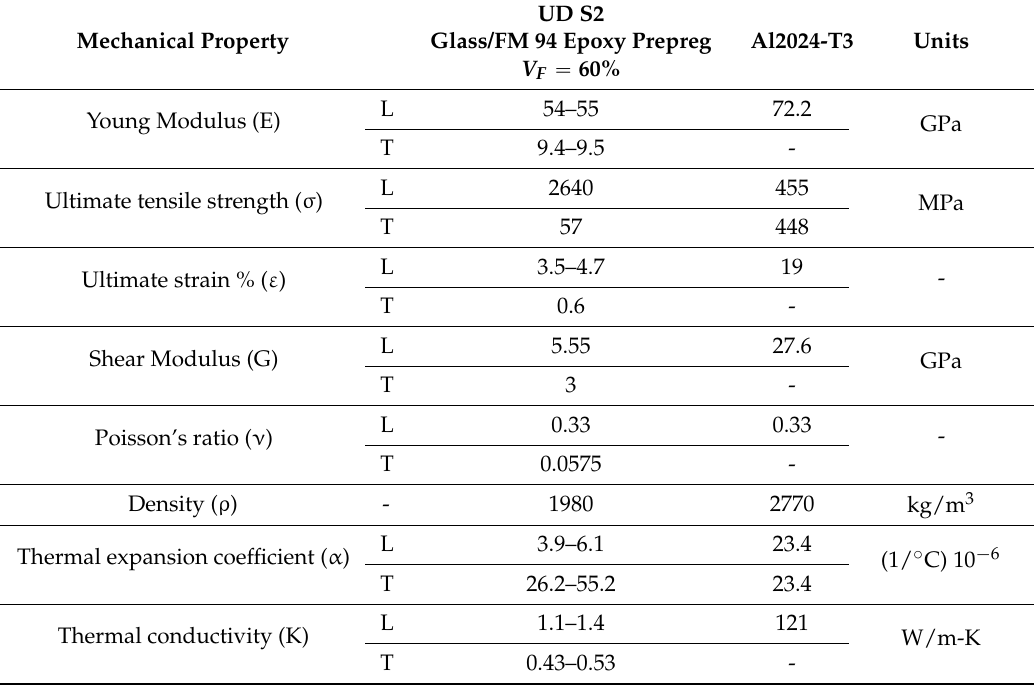
Table 3. Mechanical Properties of S2-Glass fiber prepreg and Al2024-T3 [11,62–65].